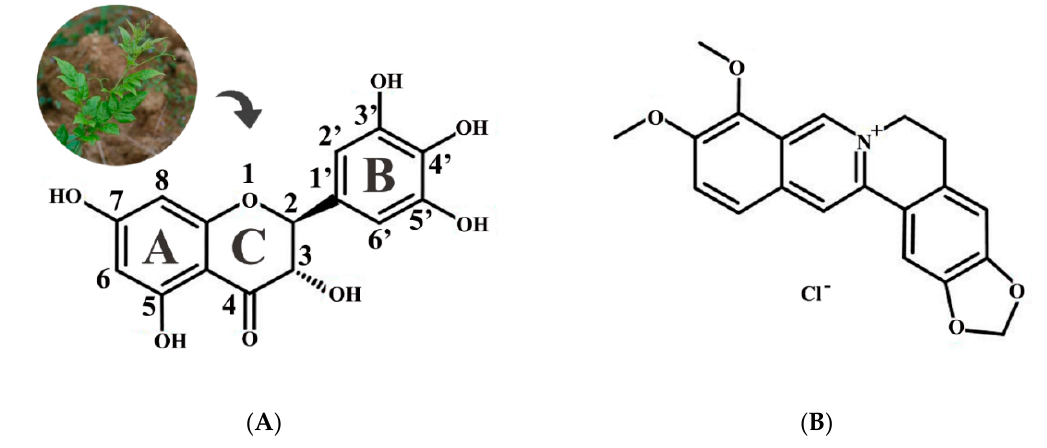
Figure 1. Chemical structures of DMY ( A ) and Berberine hydrochloride (BH) ( B